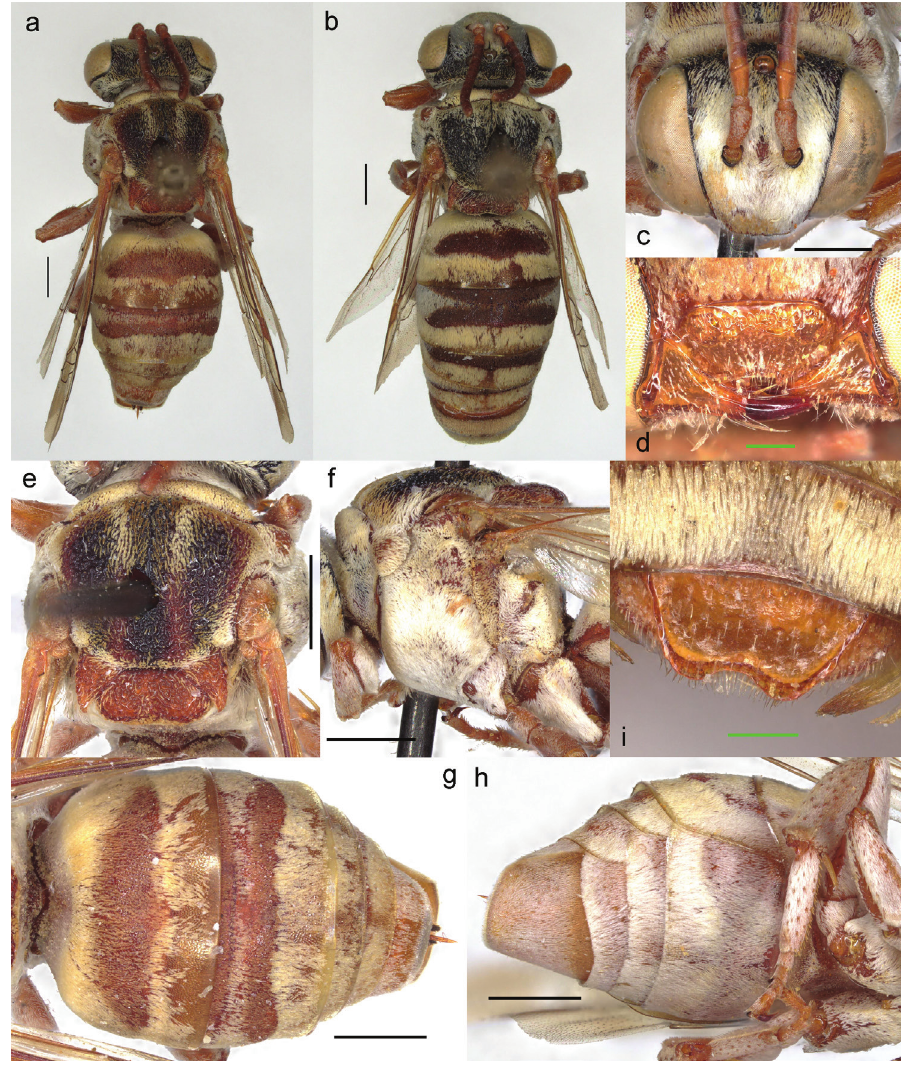
Figure 3. Epeolus seraxensis stat. nov. a, c–h lectotype, female b, i syntype, male a, b habitus, dorsal view c head, frontal view d labrum, frontal view e mesosoma, dorsal view f mesopleuron, lateral view g meta- soma, dorsal view h ventral views i pygidium, dorsal view. Scale bars: 1.0 mm ( a–c, e–h ); 0.1 mm ( d, i Clypeus reddish, matt and with very fine and dense punctation, interspaces smaller than puncture diameters. Clypeus entirely covered by whitish tomentum. Face black with basal part from clypeus to antennal tubercles reddish, with dense whitish hair around antennal socket, and with well-developed and sharp frontal keel. Vertex black, with dense punctures, interspaces shiny and smaller than puncture diameters. Antenna reddish with flagellomeres dorsally partly brownish. Flagellomeres slightly longer than wide (L/W ratio = 1.2), F2 longer than other flagellomeres (L/W ratio = 1.7) (Fig. 3c).